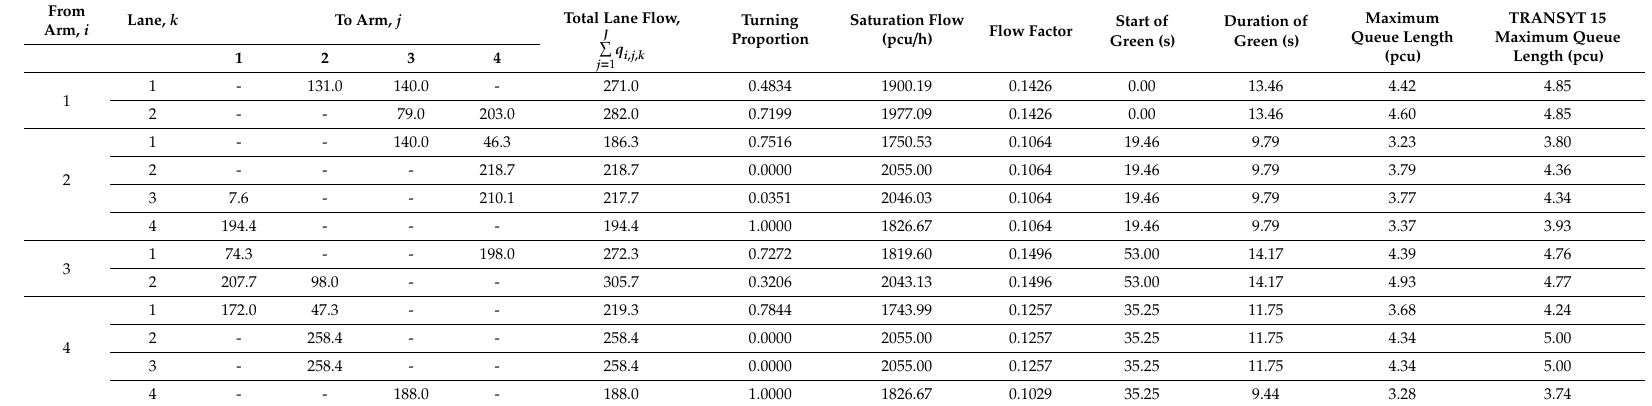
Table 4. Details of optimization results in the evening-peak period with cycle time = 73.17s and common flow multiplier 1.386.multiplier = 1.386. From Arm,